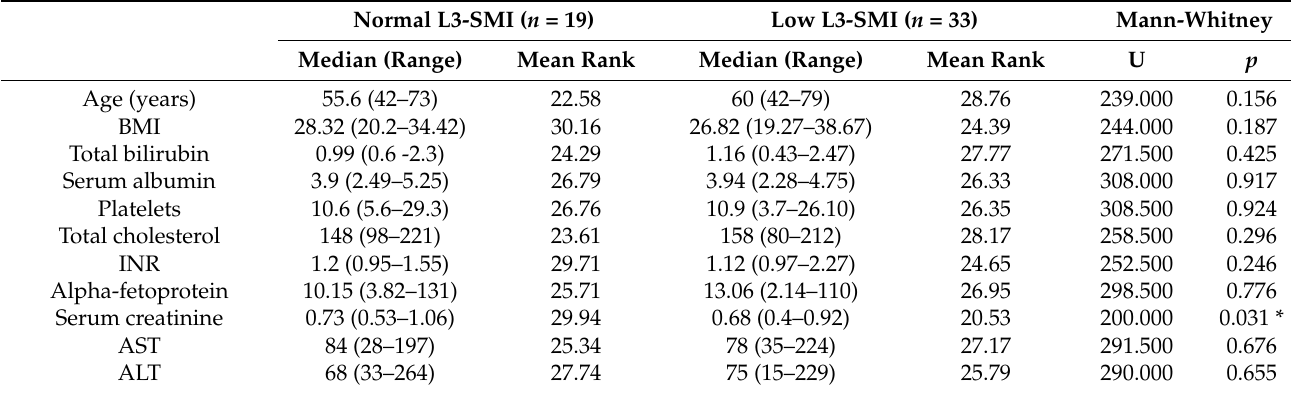
Table 2. Comparison between patients with low L3-SMI and normal L3-SMI.